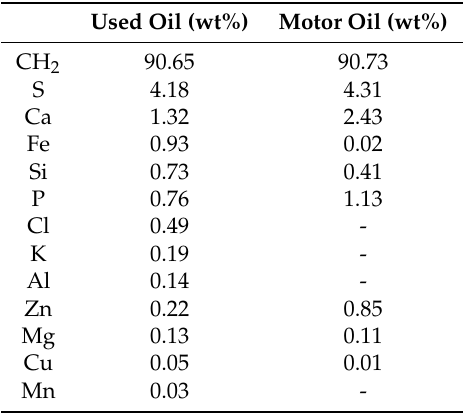
Table 1. Compositions of the used and motor